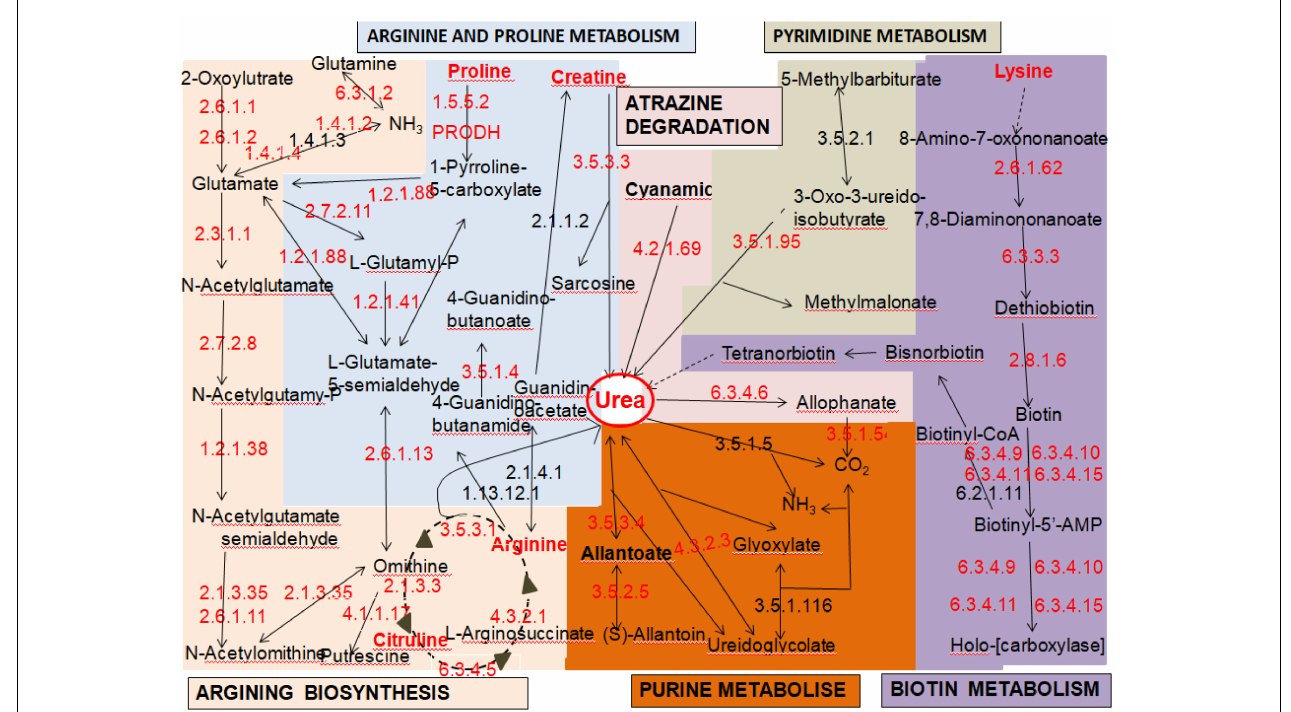
FIGURE 1 | Pathways related to the urea metabolism of S. cerevisiae strain JH301.